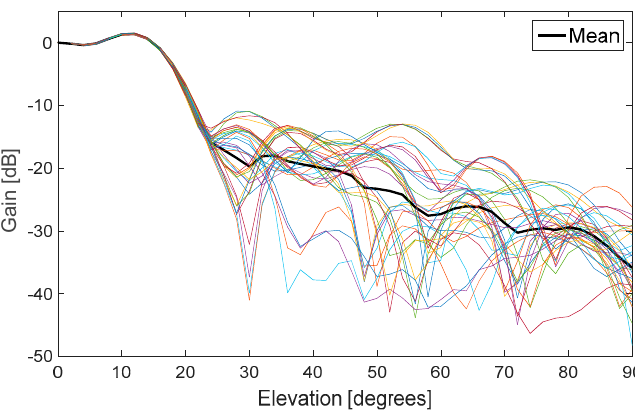
Figure 4. Block IIF GPS L1 antenna gain pattern.